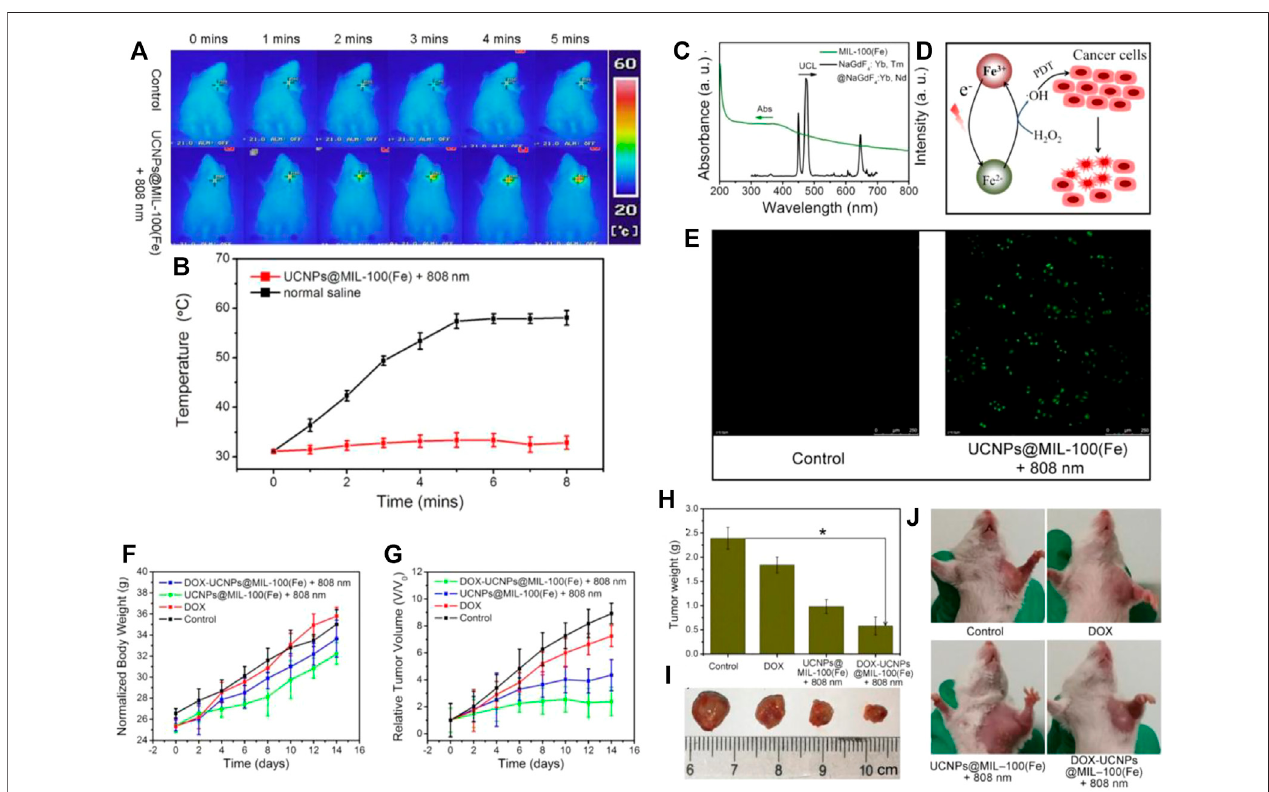
FIGURE 3 | (A) Photothermal imaging in mice and (B) The temperature rise before and after injection of MOF-Fe nanomaterials. (C) The emission spectrum of NaGdF4:Yb,Tm@NaGdF4:Yb and shell of iron ions. (D) Schematic diagram of the role of iron ions. (E) Confocal image of HeLa cells with different treatment (UCNPs@ MIL-100[Fe] NPs and control). (F) The weight of mice are treated differently. (G) The changes in tumor volume are treated differently. (H) Photos of the changes in the body weight and (I) tumor volume of mice. (J) Physical photos of mice after different treatments with control, pure DOX, and UCNPs@MIL-100(Fe)